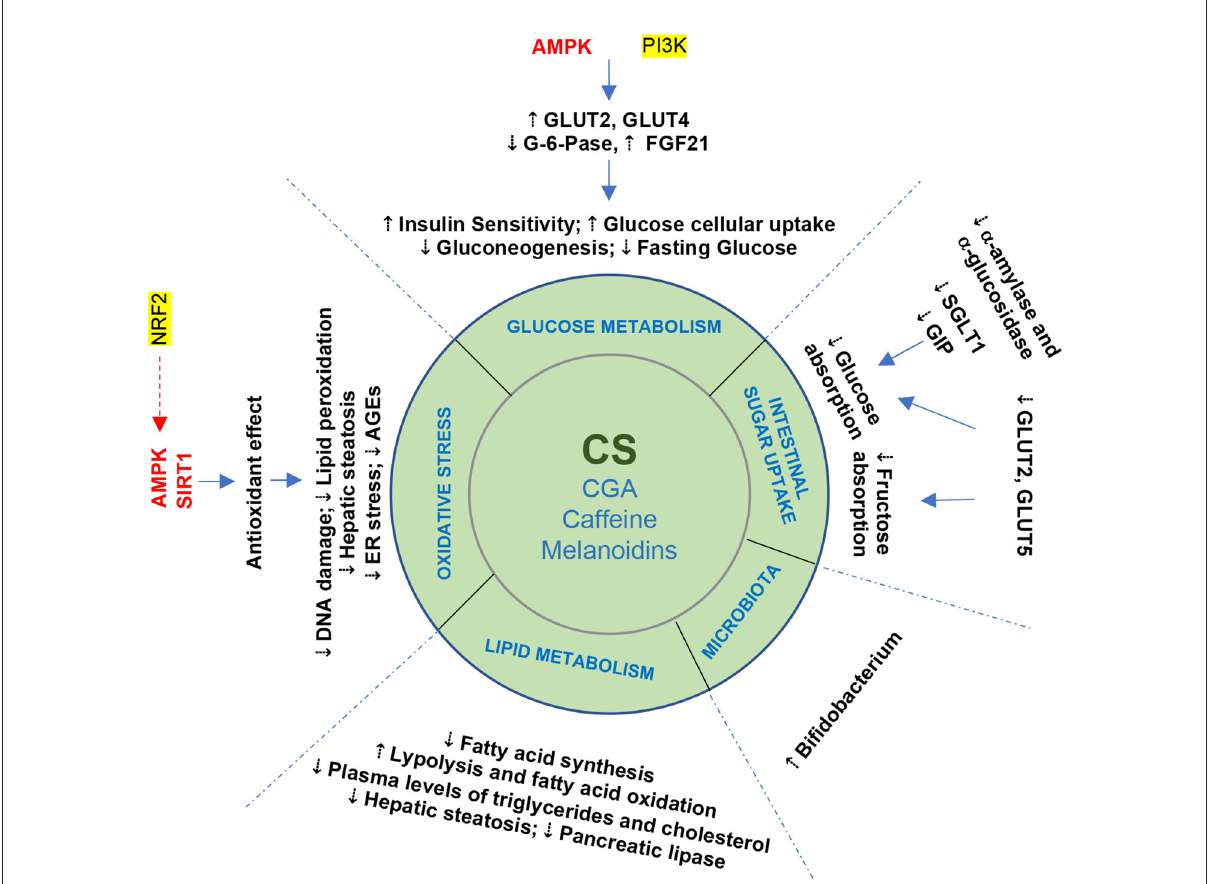
FIGURE3 Beneficial effects of coffee silverskin and its bioactive compounds on metabolic syndrome: summary of the potential mechanisms involved.